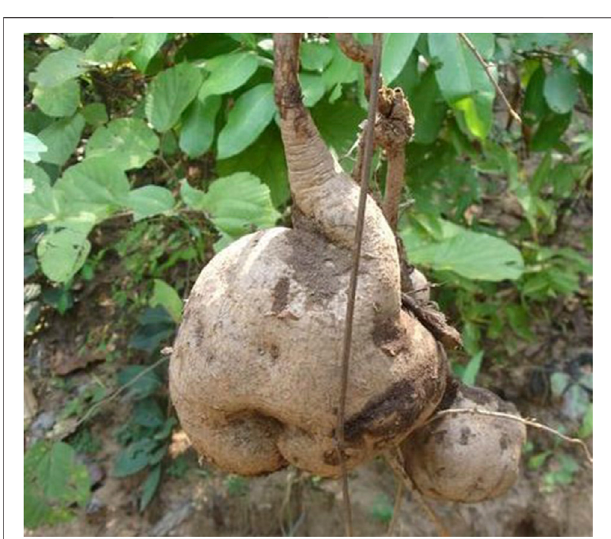
FIGURE 3 | Pankaj